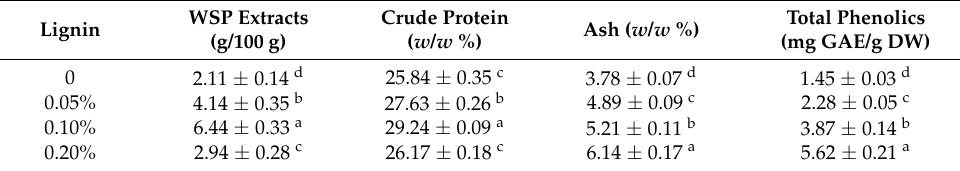
Table 1. Chemical composition of L. edodes cultured in the presence of